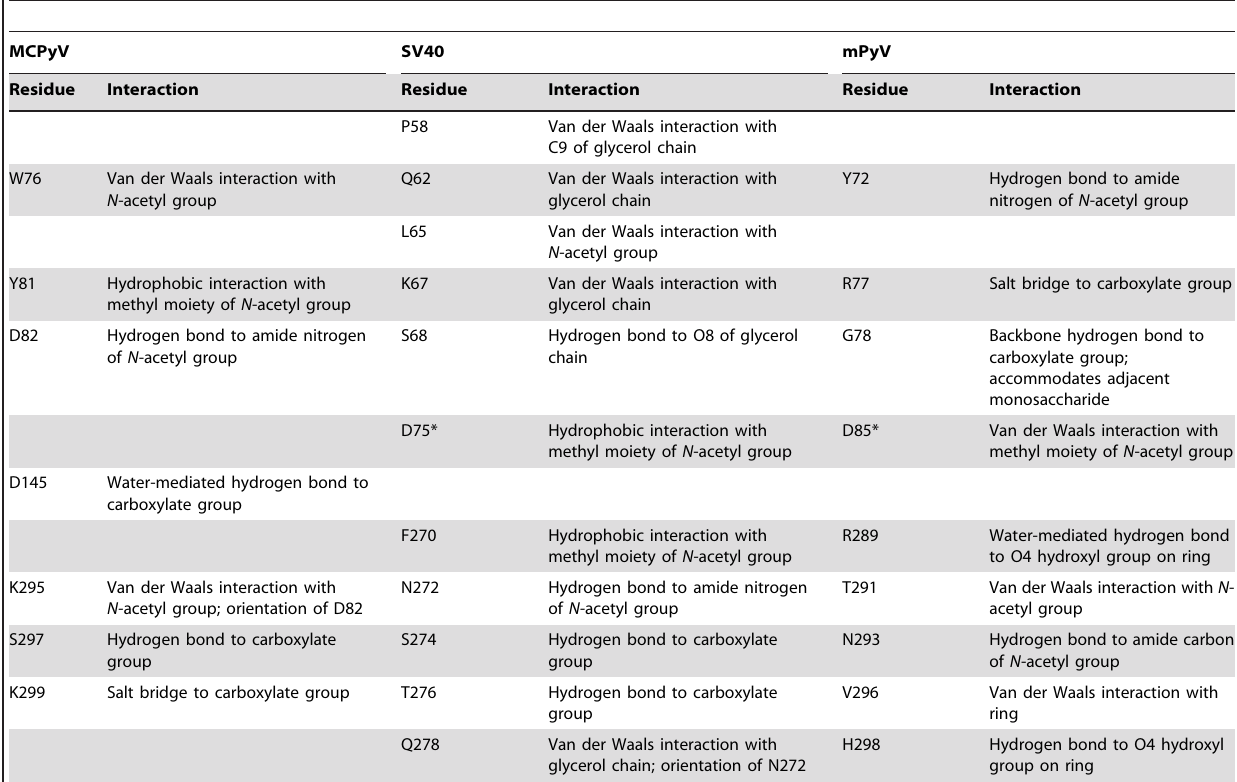
Table 2. Variable interactions with sialic acid among polyomavirus VP1 proteins.